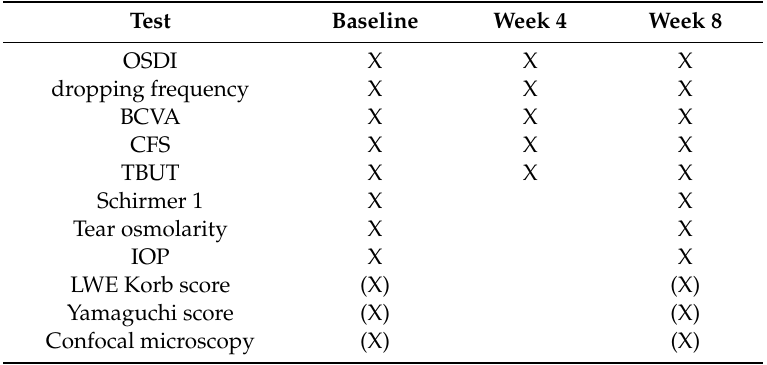
Table 1. Diagnostic testing schedule with optional tests in round